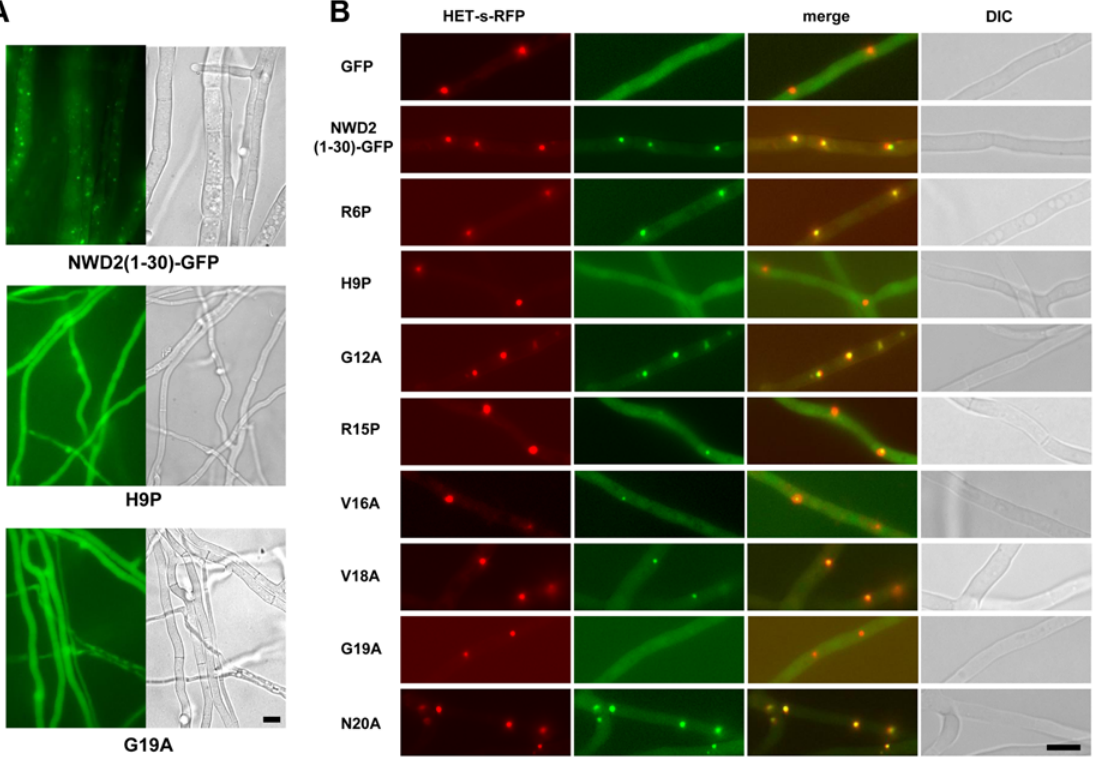
Fig 5. NWD2(1 – 30)-GFP localizes to HET-s-RFP prion aggregates. A. NWD2(1 – 30)-GFP, NWD2(1 – 30)-GFP H9P and NWD2(1 – 30)-GFP G19A were expressed Δ het-s strain. Wild-type but not mutant fusion proteins formed dot-like aggregates, scale bar is 5 μ . B. Co-expression of HET-s-RFP with GFP, NWD2(1 – 30)-GFP and eight point mutants of NWD2(1 – 30)-GFP, scale bar is 5 μ